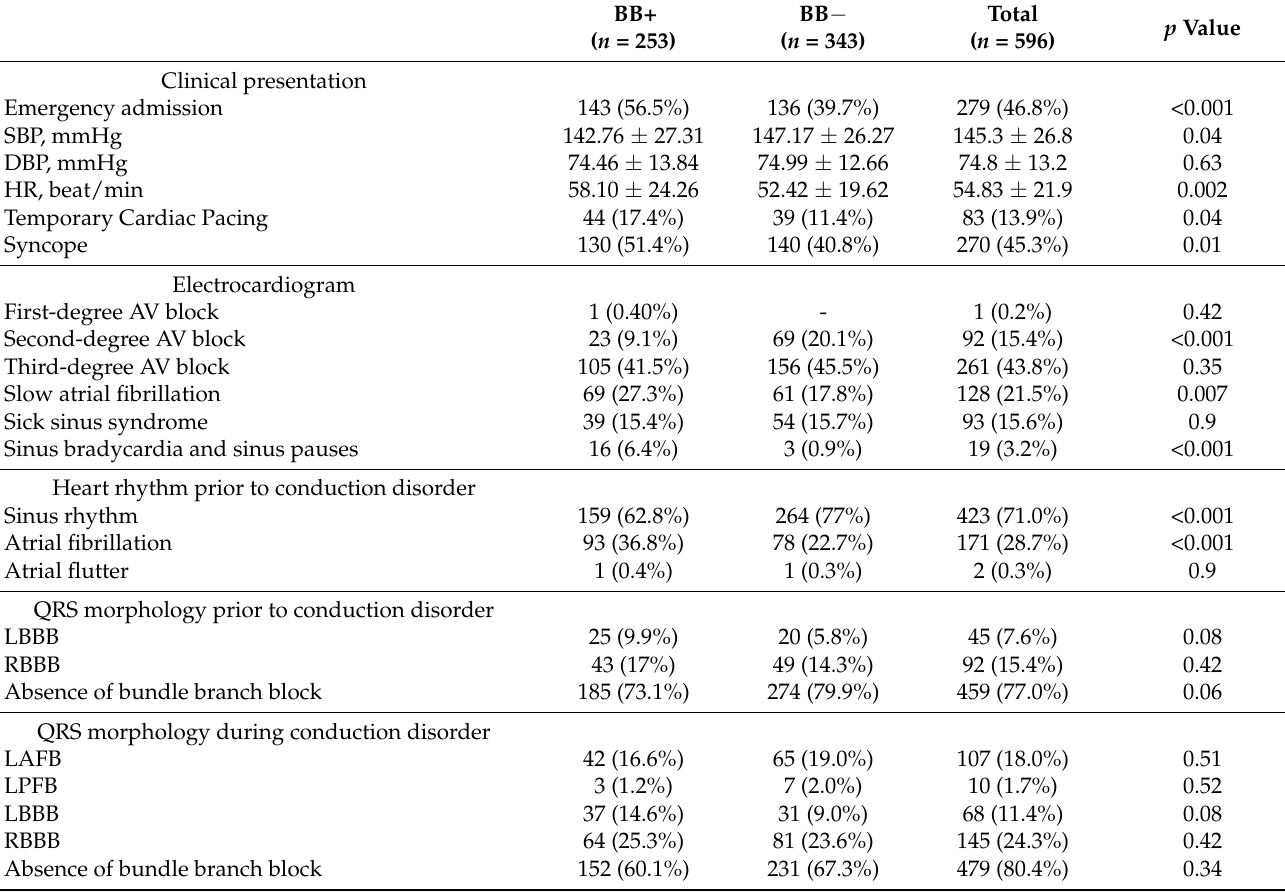
Table 2. Clinical and ECG